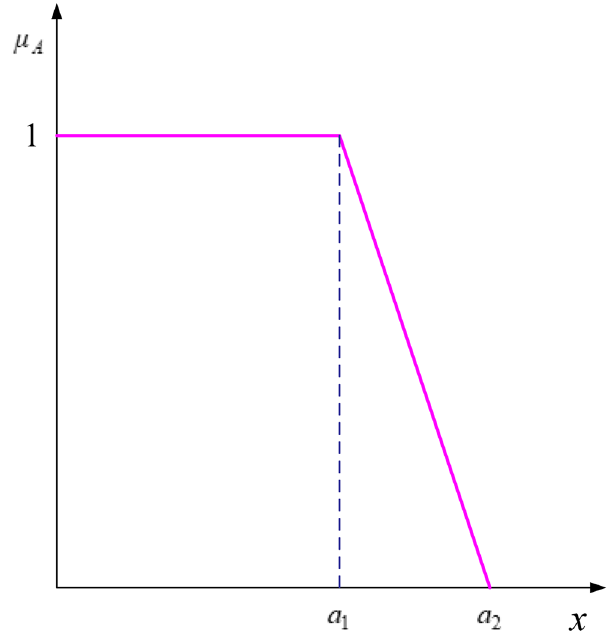
Fig. 2. Schematic diagram of membership function.